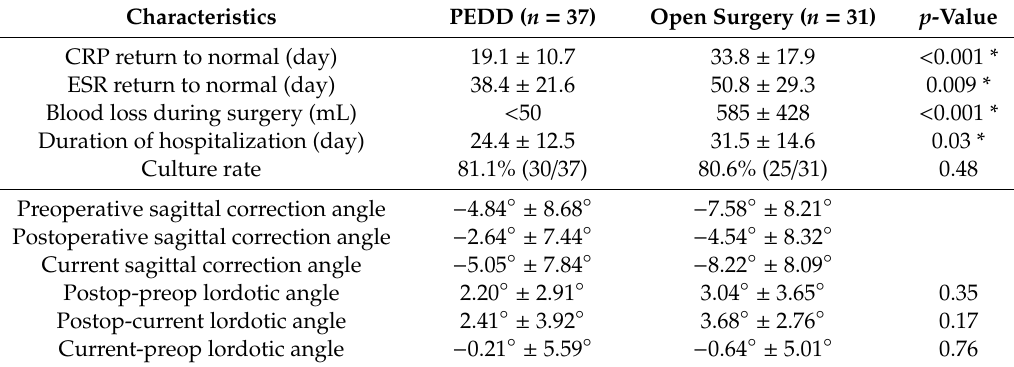
Table 2. Clinical and radiographical